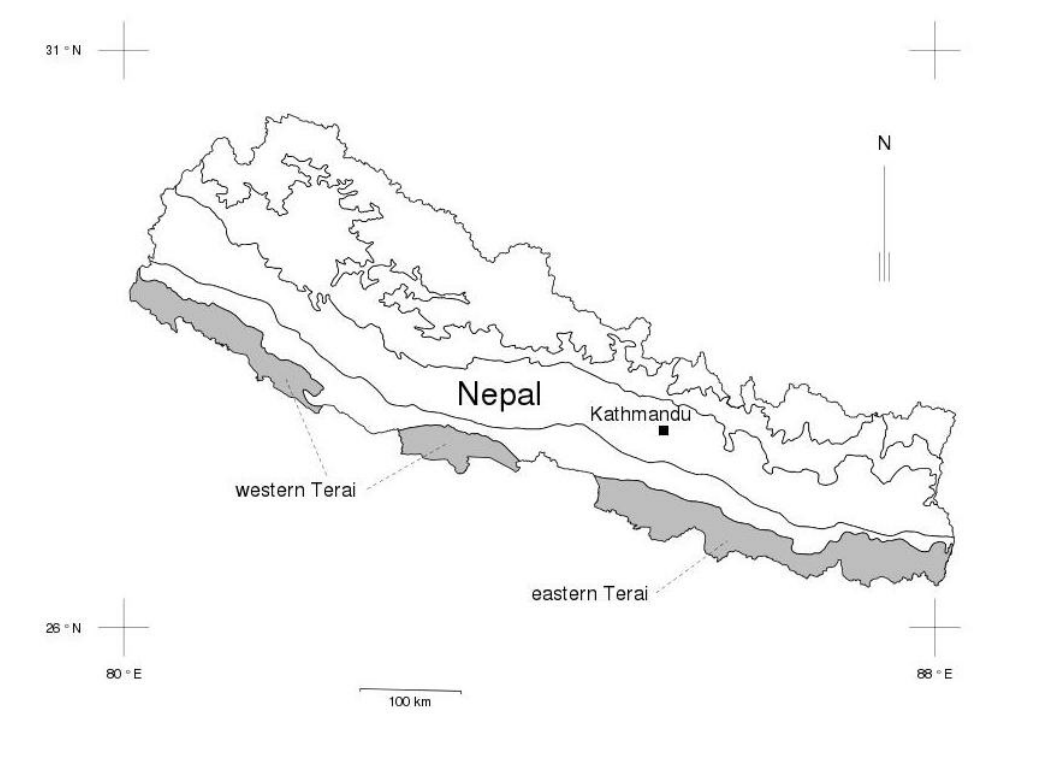
Table 1. Information about the Landsat TM satellite imagery used in this study. Path and row information is given in the WRS-2